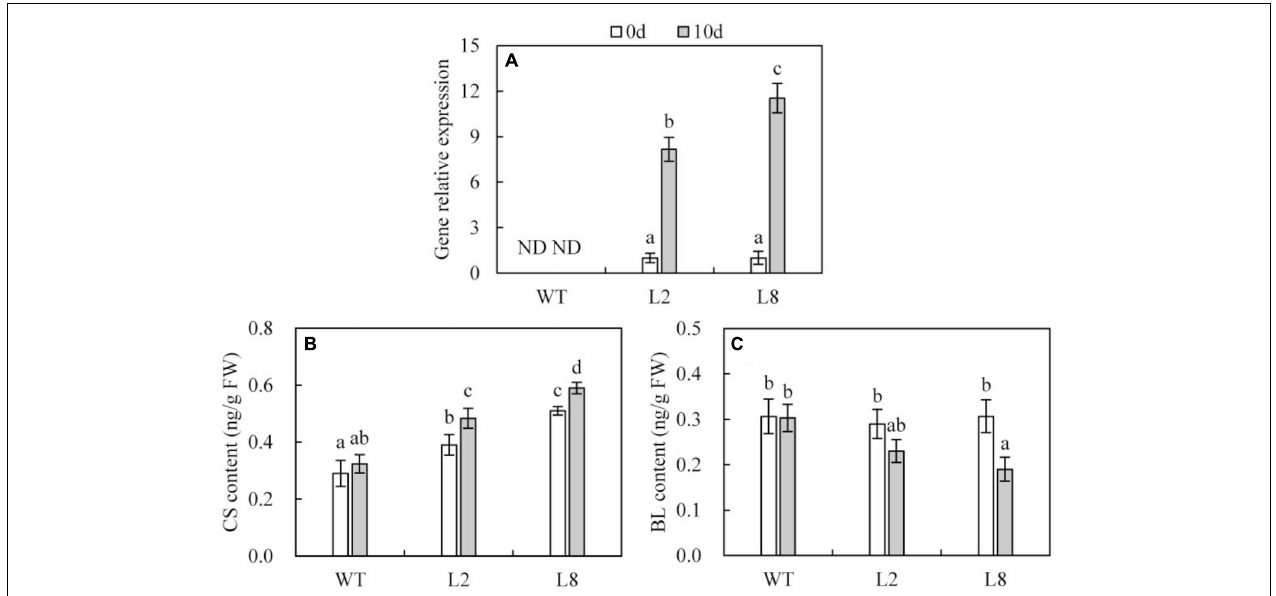
FIGURE 4 | BRs biosynthesis capacity in WT and overexpressing lines (L2 and L8). (A) Transcriptional accumulations of the SoCYP85A1 gene in WT, L2 and L8 before and after 10-day drought stress. The expression level of L2 and L8 at time point 0 was defined as 1, respectively. (B) Detection of CS content. (C) Detection of BL content. CS, castasterone; BL, brassinolide; FW, fresh weight. The leaves from tobacco plants at 6-week-old stage were sampled for BRs analysis before and after 10-day water loss. Data are the means ± SD of three replicates and values with different letters are significant at P < 0.05.